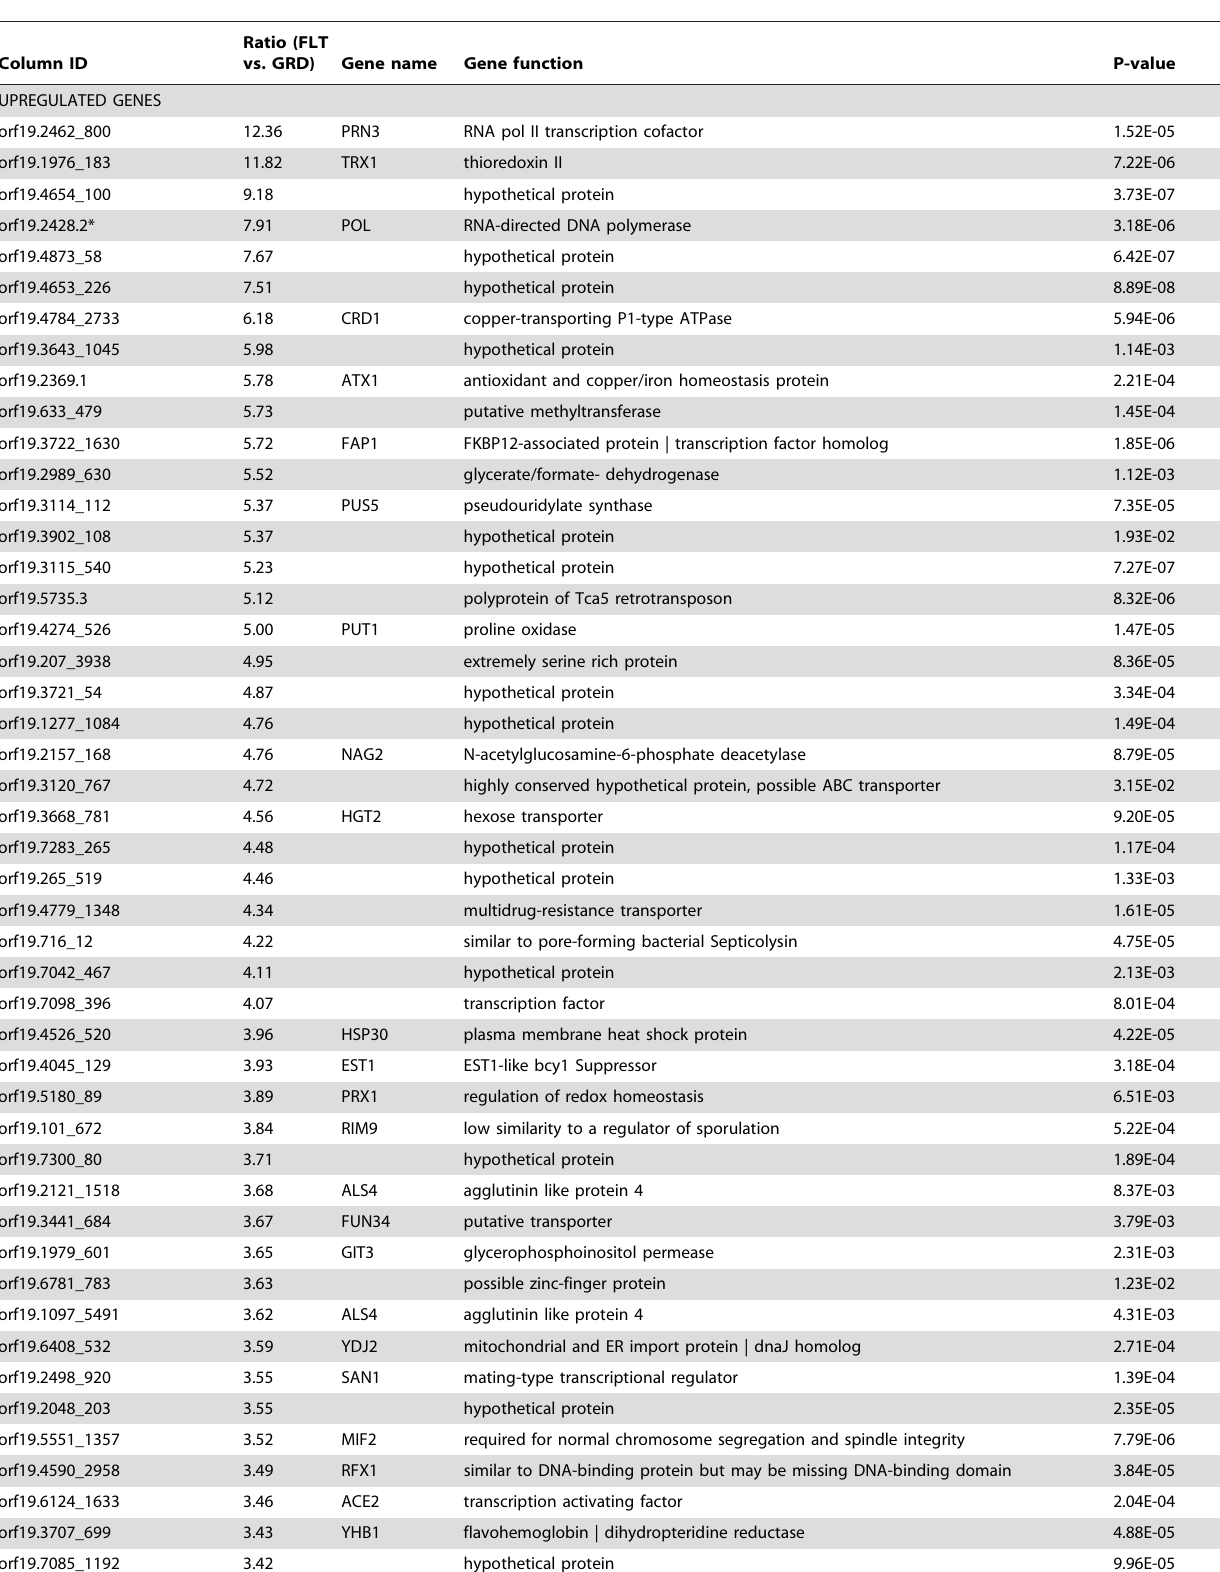
Table 2. Differentially regulated genes of C. albicans grown in spaceflight conditions as compared to ground control (p , 0.05, fold-change .